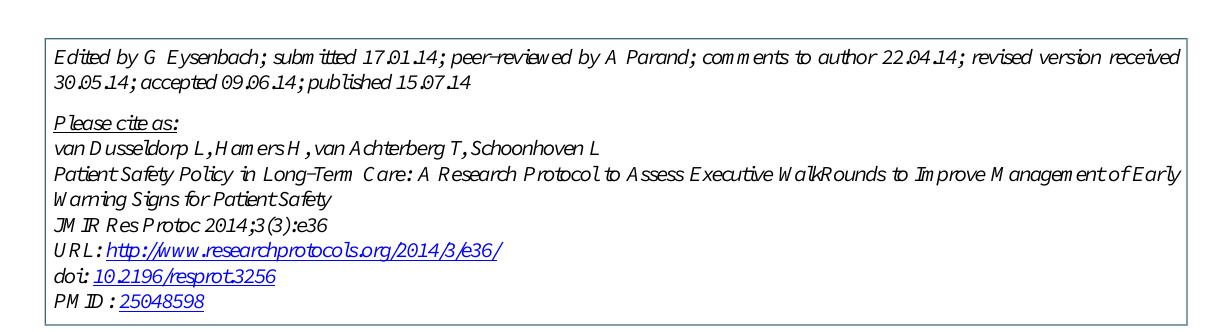
reproduction in any medium, provided the original work, first published in JMIR Research Protocols, is properly cited. The complete bibliographic information, a link to the original publication on http://www.researchprotocols.org, as well as this copyright and license information must be